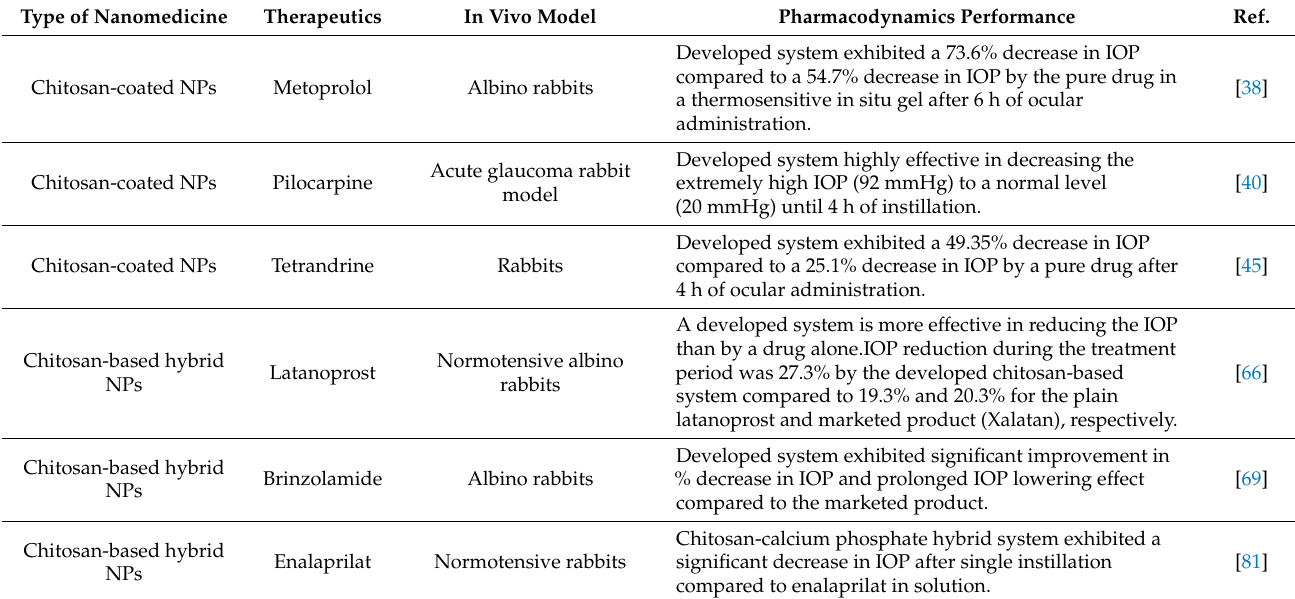
Table 3. Chitosan-based nanomedicine utilized to improve the pharmacodynamics performance of loaded